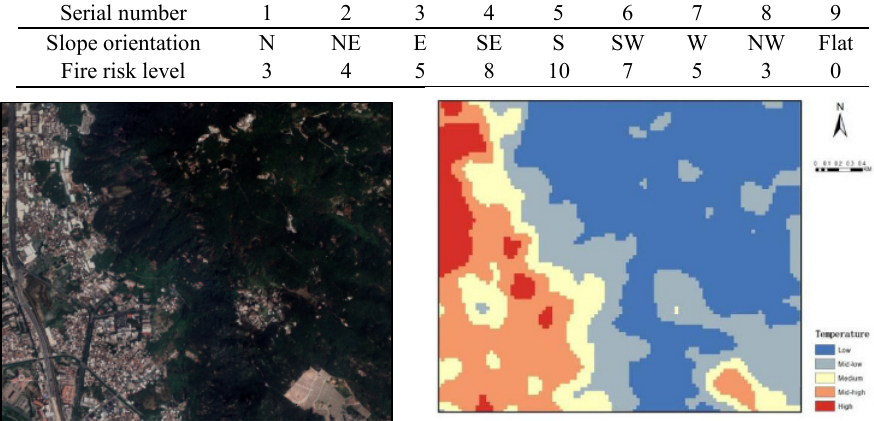
Table 2. Slope direction factor fire risk rating table.